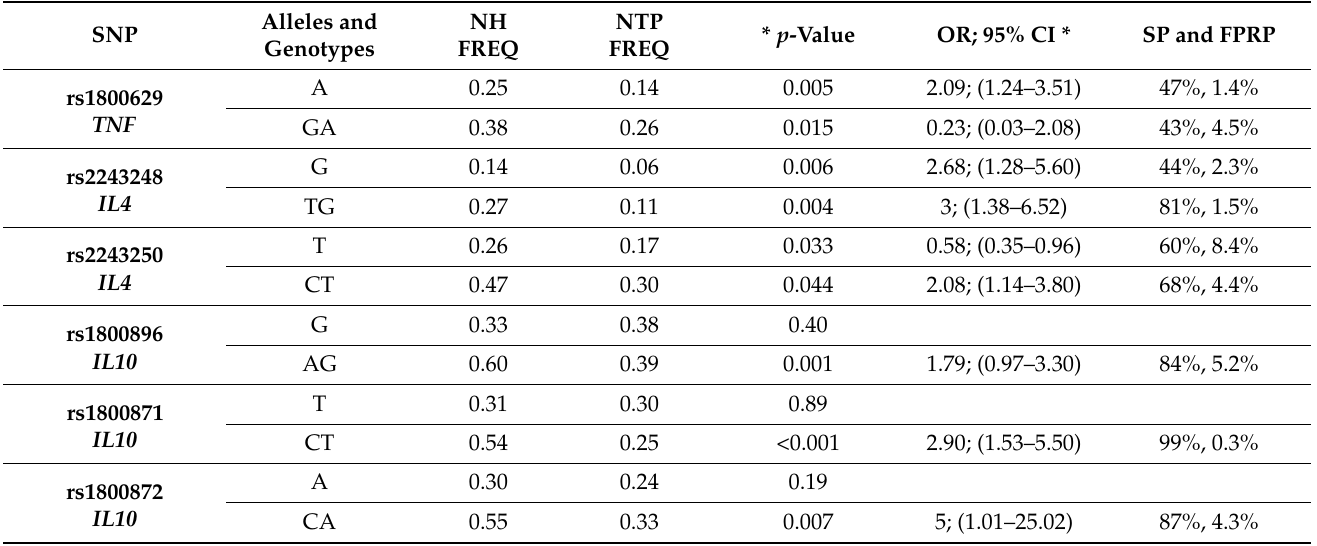
Table 5. Comparative study of allelic and genotypic frequencies between patients with NSAID hypersensitivity and NSAID-tolerant